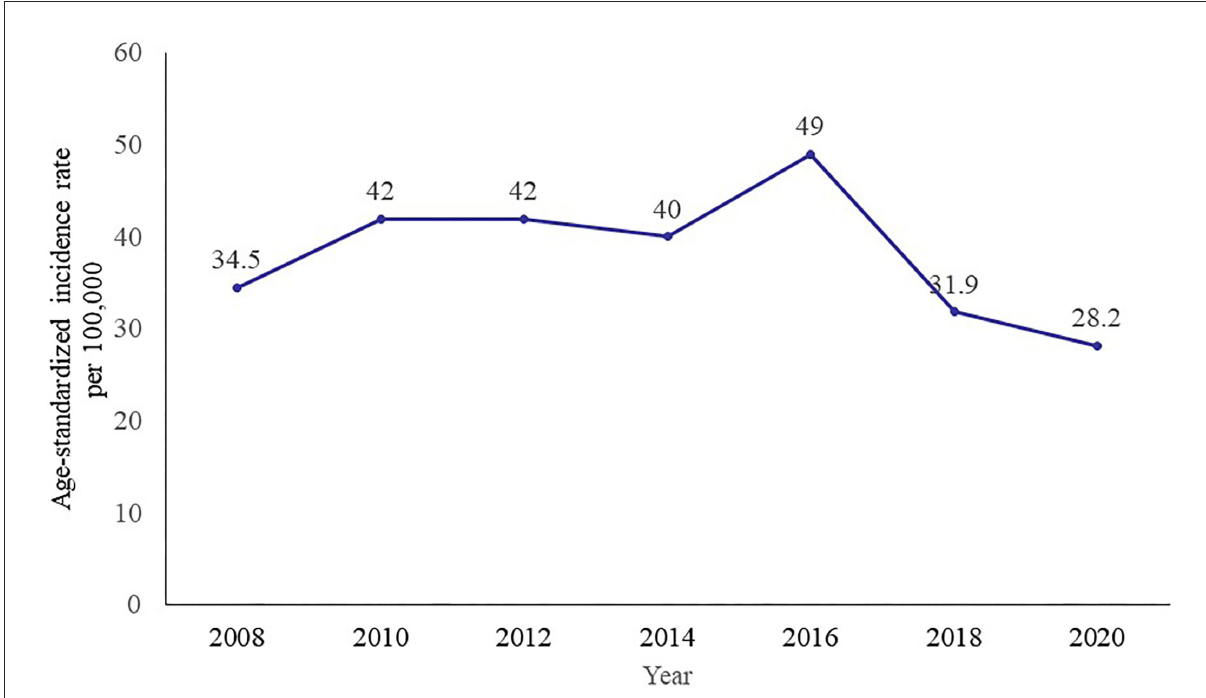
FIGURE1 Trend of age-standardized incidence rate of cervical cancer in Rwanda, 2008–2020. Data source: IARC.